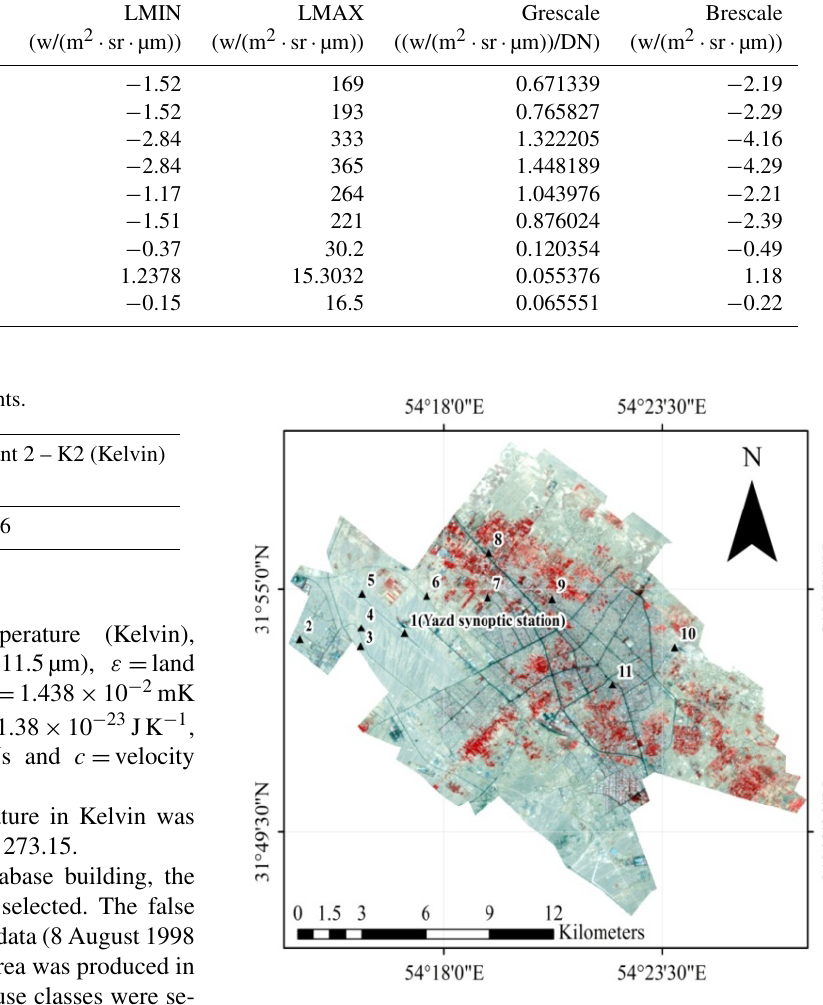
Figure 2. Location of the land surface temperature measurement